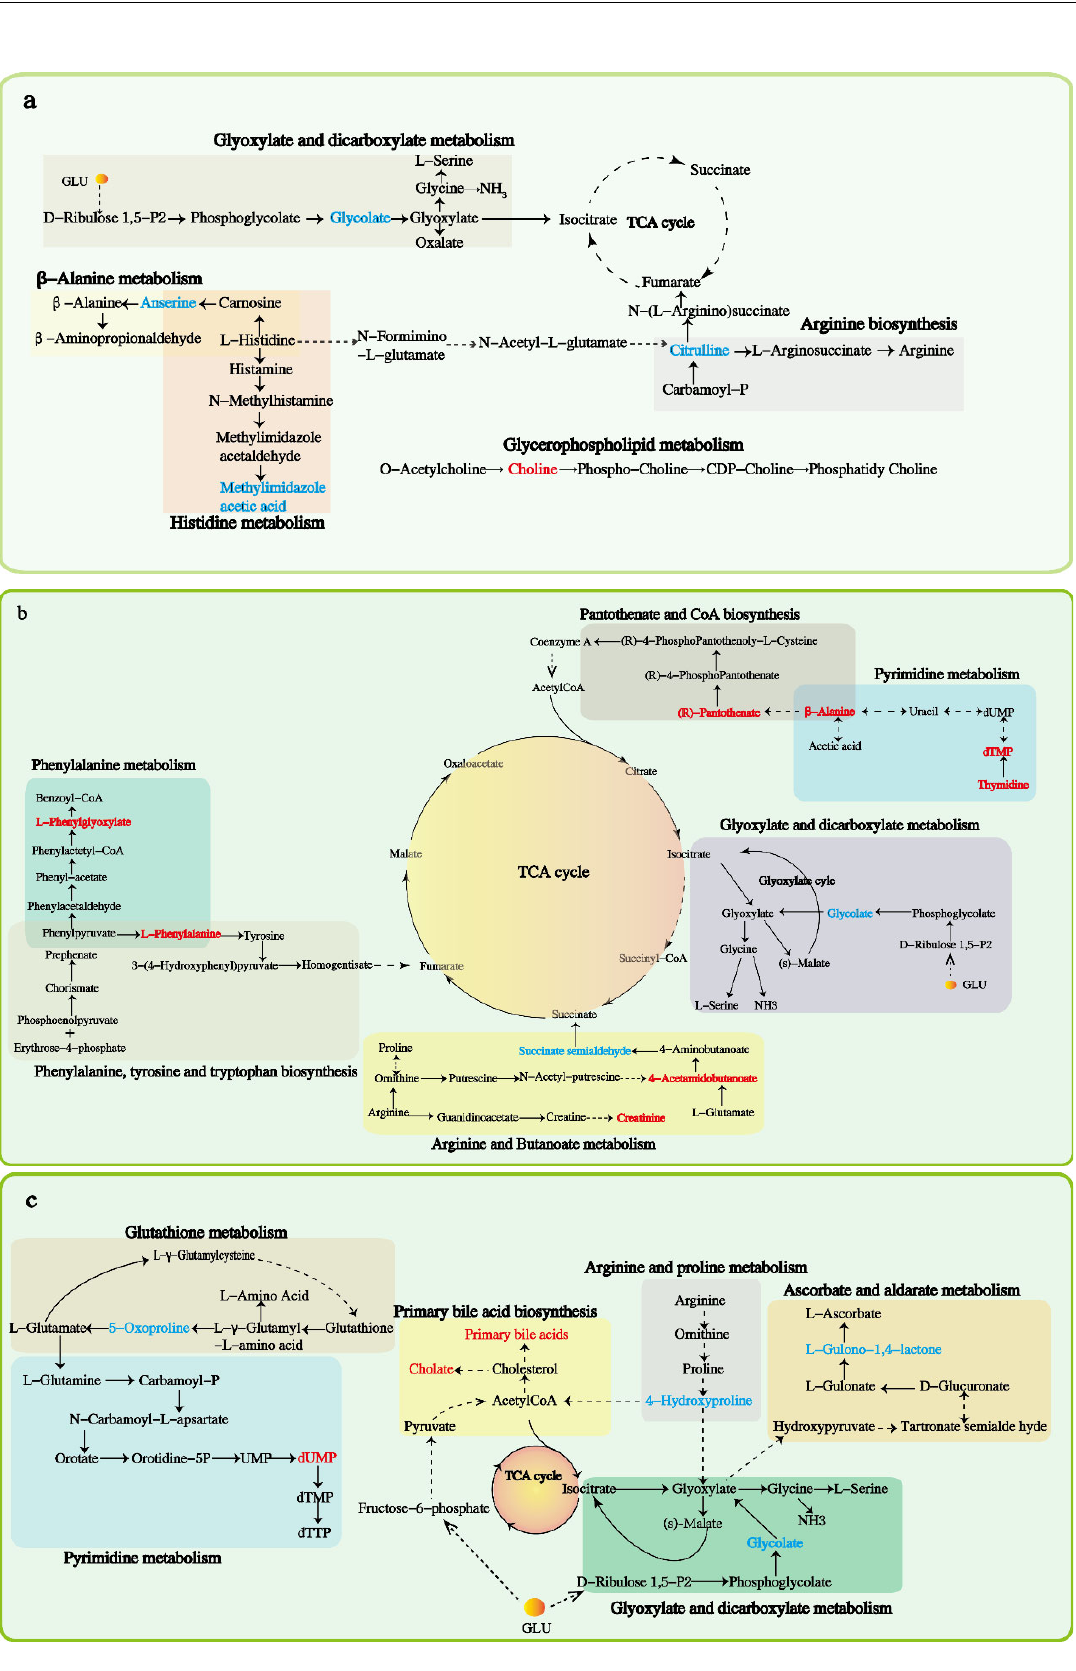
Figure 6. Network graph for the early weaned yak calves consuming herbal root extracts. The red metabolites represent down-regulation, and the blue metabolites represent up-regulation: ( a ), Angelica sinensis group; ( b ), Codonopsis pilosula group; ( c ), Glycyrrhiza uralensis group.